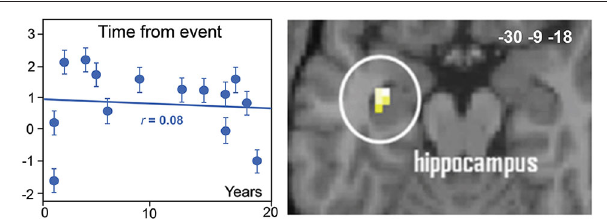
FIGURE 6 | Neural basis of odor-evoked autobiographical memory . The blood oxygen level-dependent signal in the hippocampus region of interest did not significantly vary with the time from the event (adapted from Arshamian et al.,